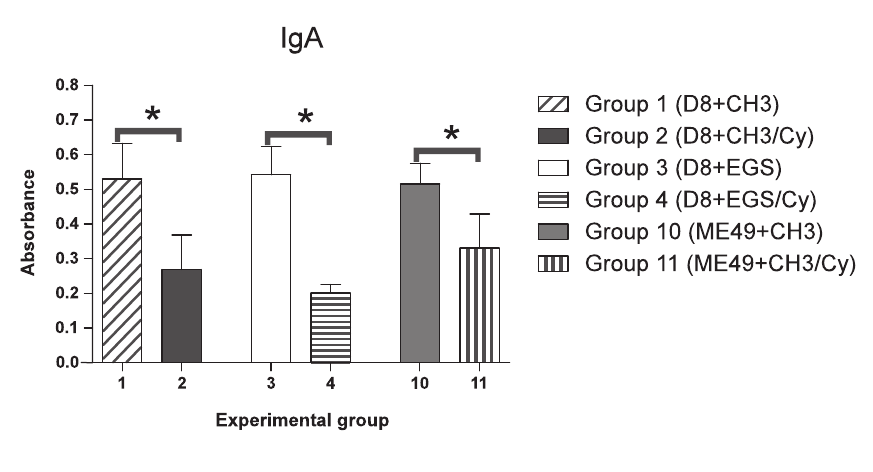
Fig. 3. – Specific IgA antibodies to Toxoplasma gondii detected by ELISA in BALB/c mice sera collected 30 days after challenge. * significant difference between the Cy-immunosuppressed group com- pared to respective non-immunosup- pressed group primary infected and challenged with the same strains of T. gondii , p <